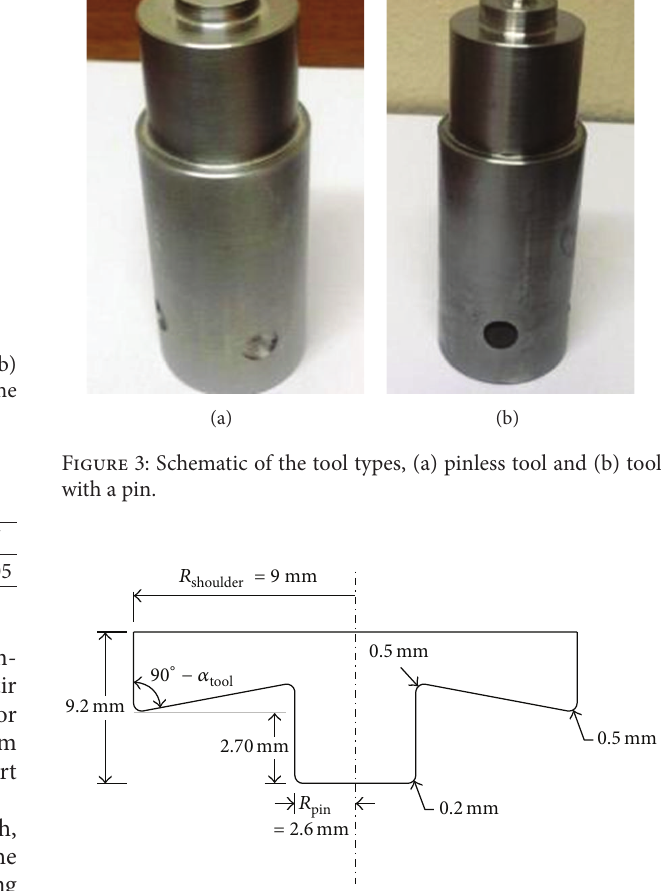
Figure 4: Tool dimensional drawing showing the pin and shoulder.